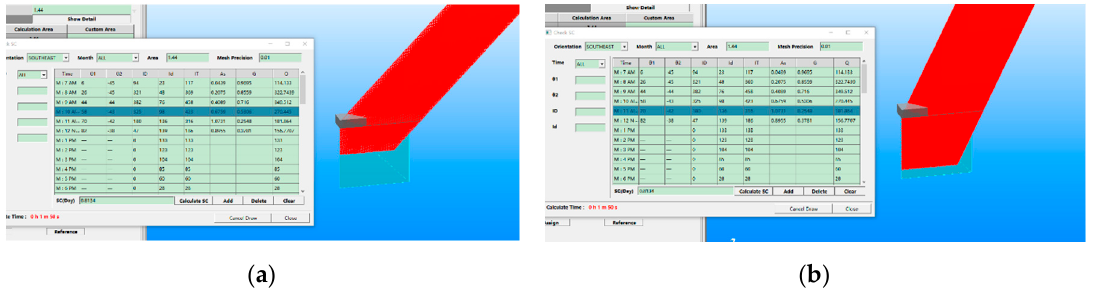
Figure 11. Three-dimensional view of solar ray shading effects.